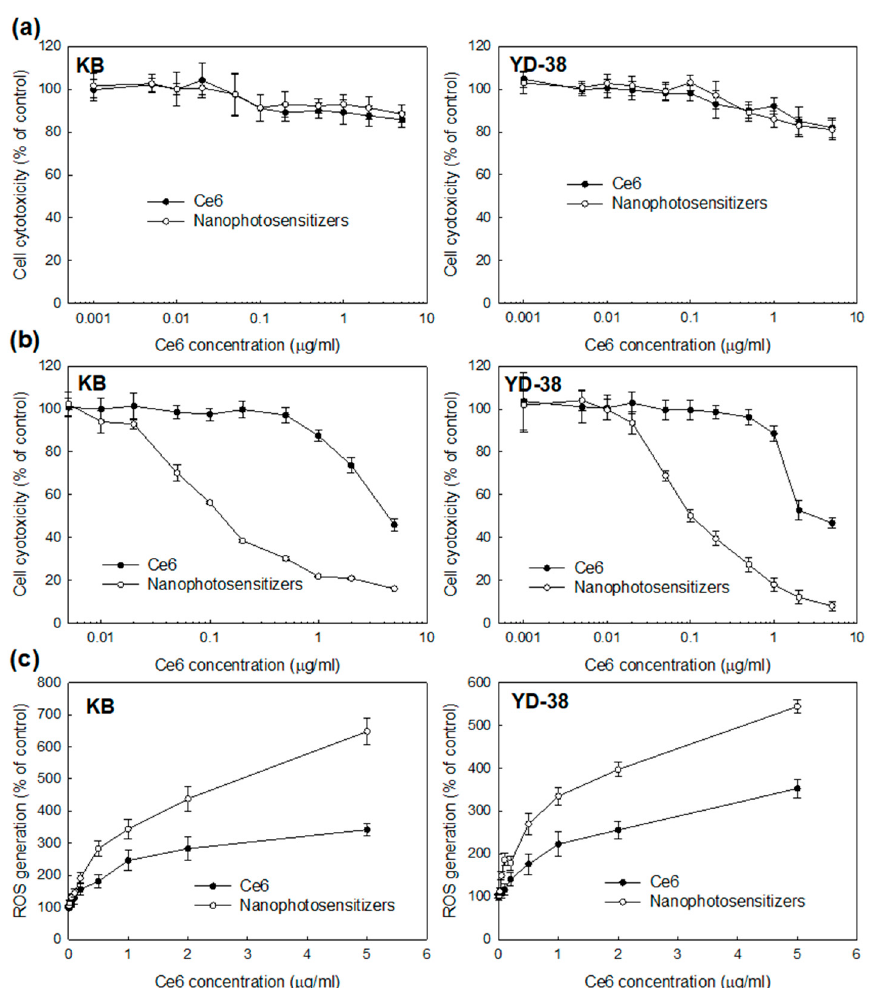
Figure 5. Photodynamic therapy (PDT) efficacy of FA–PEG 3500 -ss-Ce6tri copolymer